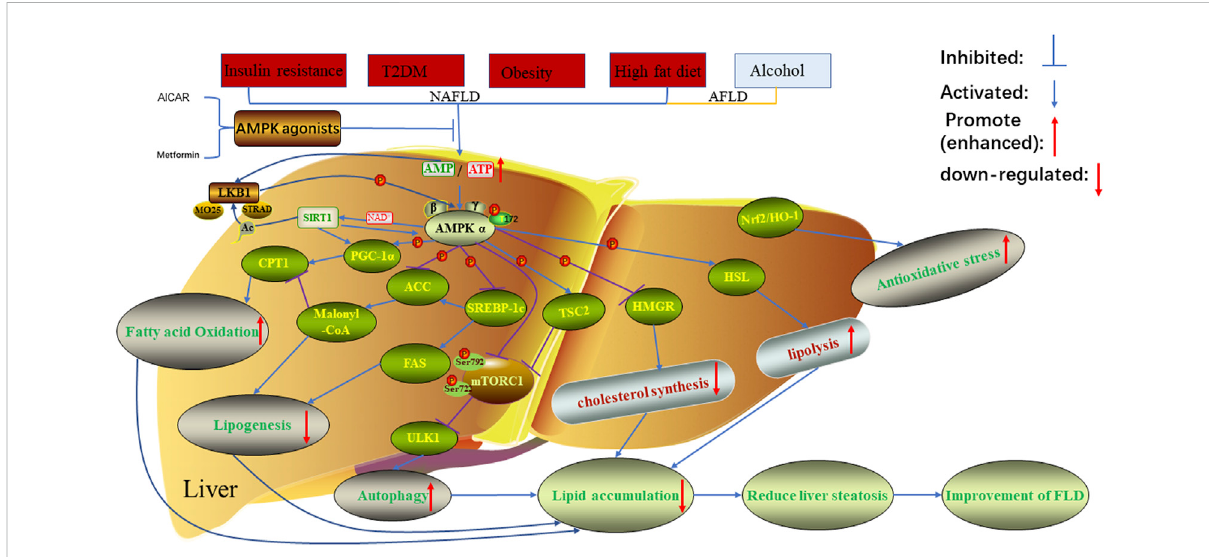
FIGURE 1 Regulation of AMPK on lipid metabolism in FLD. In the case of non-alcoholic fatty liver disease caused by insulin resistance, type 2 diabetes, obesity,high-fatdietandalcoholicfattyliverdiseasecausedbyalcohol,therelatedproteinsinAMPKsignalingpathwaywillbeinhibitedorpromoted, resulting in increased lipid accumulation and decreased fatty acid oxidation. This was reversed when AMPK was treated with AMPK agonists. AMPK, AMP-activated protein kinase; AICAR, 5-aminoimidazole-4-carboxamide ribonucleotide; LKB1, Liver kinase B1; the auxiliary subunit STRAD, STE20 related adaptor protein, and MO25, Mouse protein 25; Sirt1, Silent mating type information regulation two homolog1; CPT1, carnitine acyltransferase one; PGC-1 α , peroxisome proliferator-activated receptor γ co-activator -1 α ; ACC, acetyl-CoA carboxylase; SREBP-1c, Sterol regulatory element-binding protein 1c; FAS, fatty acid synthase; TSC2; mTORC1, mammalian target of rapamycin1; ULK1, unc51 like kinase one; HMGR, 3-hydroxy-3-methylglutaryl-CoA reductase; HSL, Hormone-Sensitive triglyceride lipase; Nrf2/HO-1, nuclear factor erythroid 2-related factor 2/heme